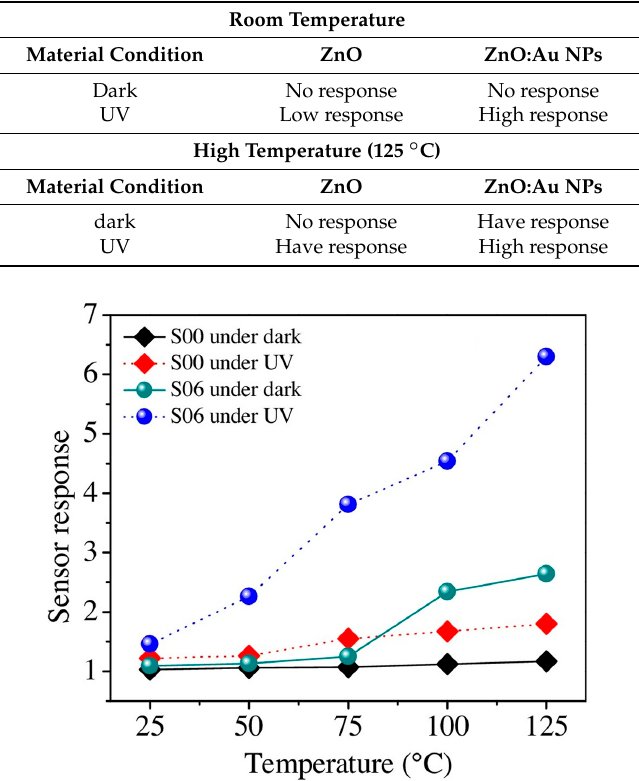
Figure 60. 1000 ppm ethanol sensing response of bare ZnO (S00) and Au NPs decorated ZnO at the sputtering time of 6 s (S06) sensors under dark condition and UV illumination with intensity at 4.1 mW/cm 2 . Reproduced with permission from [88].